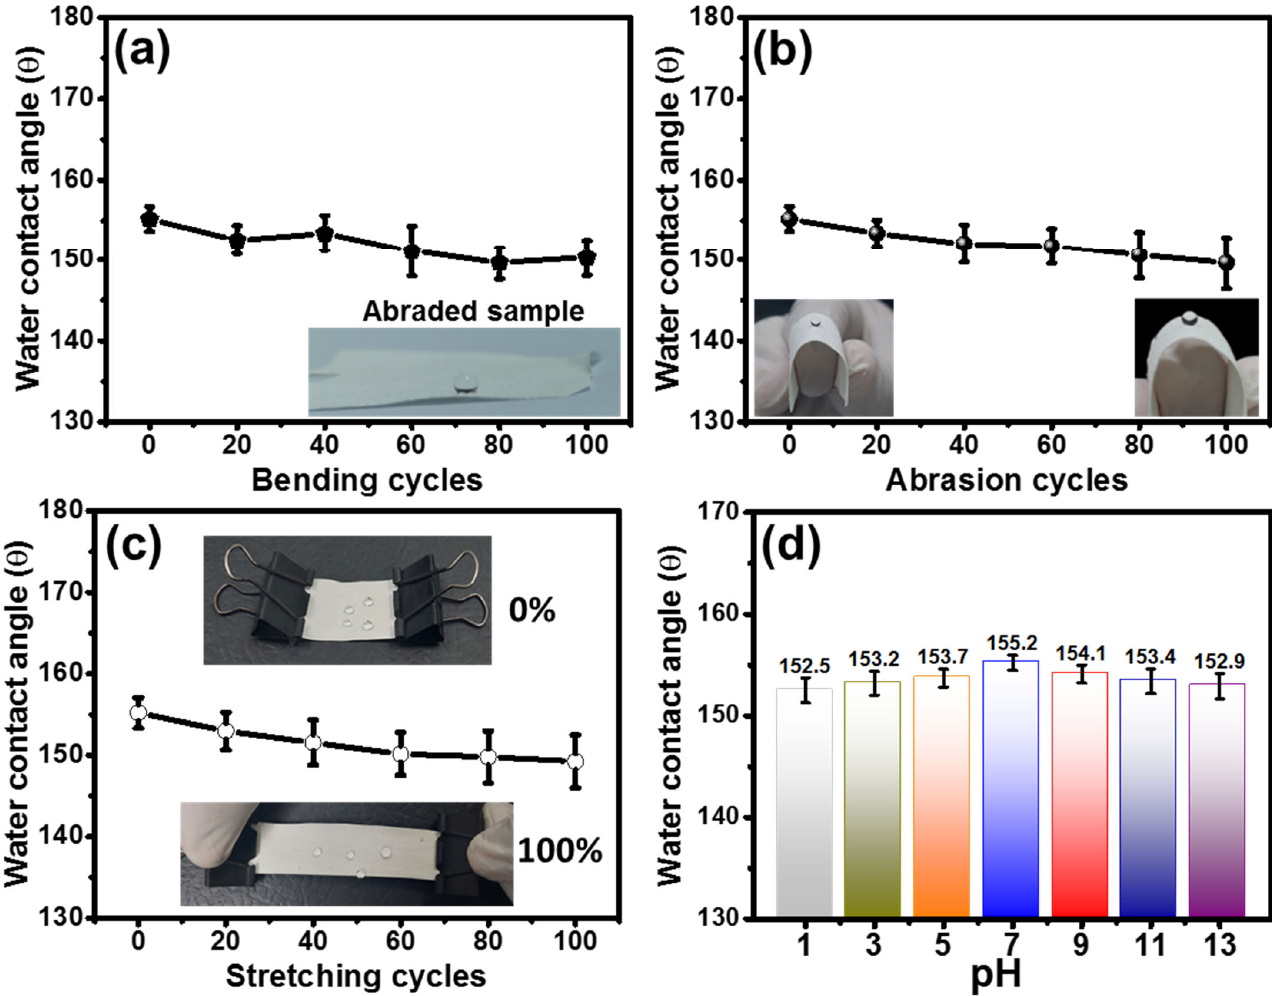
Figure 6. Robustness of the WCA of SiO 2 @PU − NFs membrane against the ( a ) bending cycles, ( b ) abrasion test, ( c ) uniaxial stretching cycles, ( d ) acidic and alkali environmental conditions.